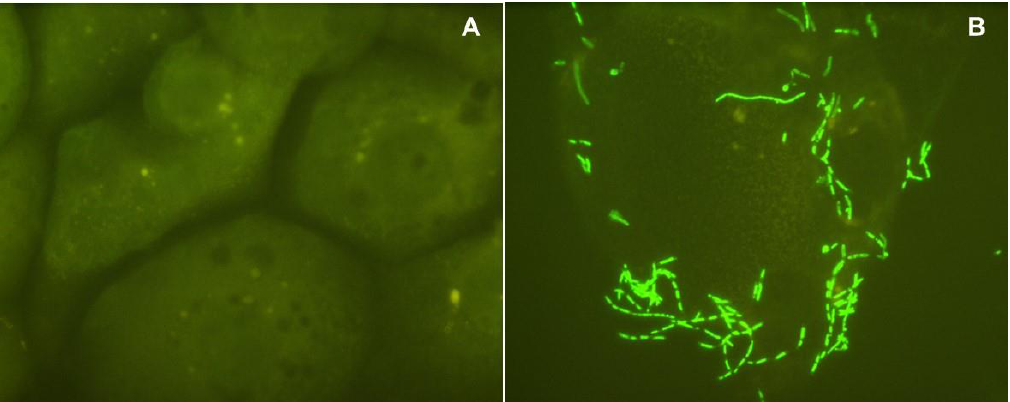
Figure 1. Phase contrast image (1000× magnification) of non-immortalized intestinal porcine derived jejunal cells (IPEC-J2) challenged with 10 8 cells of a green fluorescence protein (GFP)-labeled Salmonella Typhimurium previously exposed for 10 min to 0 or 18 mg wood-derived prebiotic/mL of medium. Results show that IPEC-J2 cells challenged with the GFP-labeled S. Typhimurium cells previously exposed to the wood-derived prebiotic product were qualitatively bound by far fewer GFP-labeled S. Typhimurium ( A ) than IPEC-J2 cells challenged with GFP-labeled S. Typhimurium having no exposure to the wood-derived prebiotic product ( B ). Microorganisms 2020 , 8 , x FOR PEER REVIEW